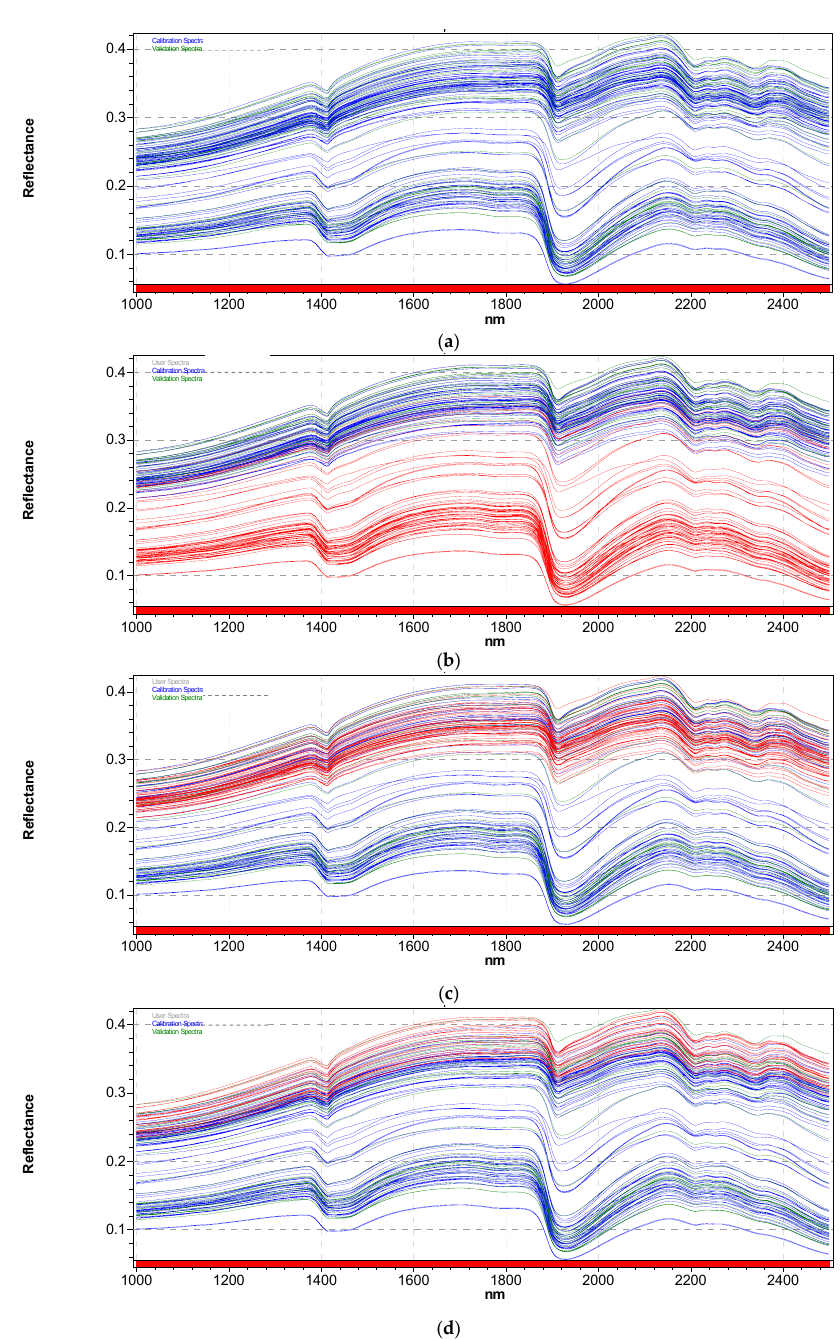
Figure 2. NIR absorbance spectra of ( a ) all soils sample sets; ( b ) the wet sample (WS) set highlighted in red; ( c ) the dried sample (DS) set highlighted in red; ( d ) the ground and sieved sample (GSS) set highlighted in red.